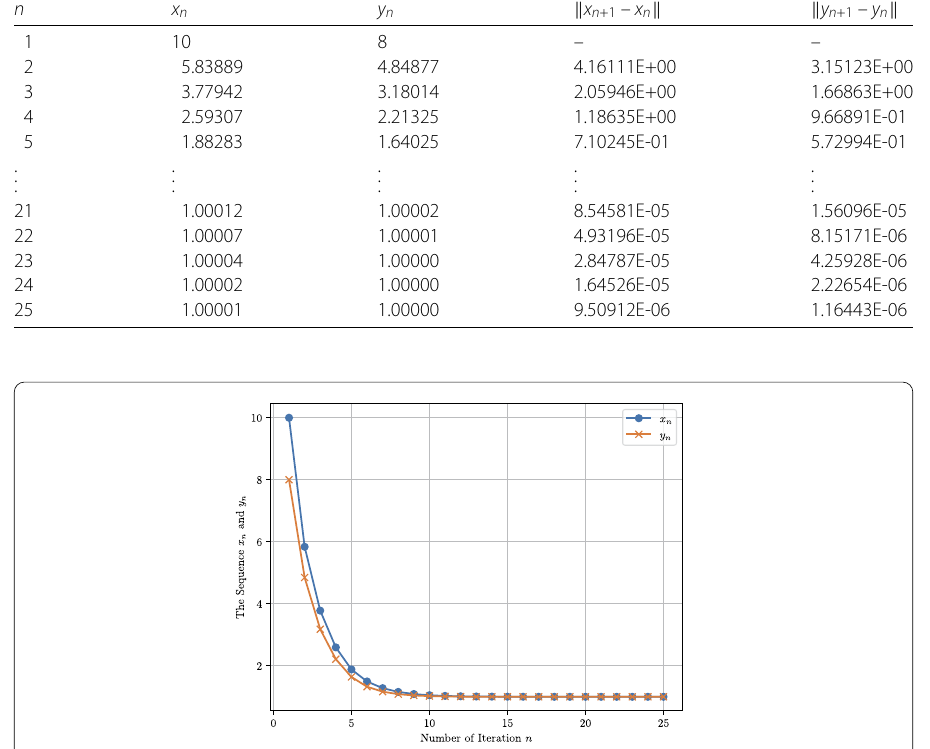
Figure 1 The convergence behavior of { x n } and { y n } with x 1 = 10, y 1 = 8 in Example 5.1